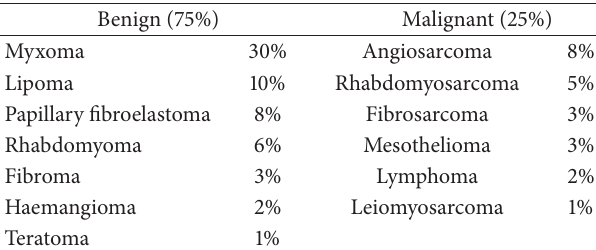
Table 1: Relative frequency of primary cardiac tumours